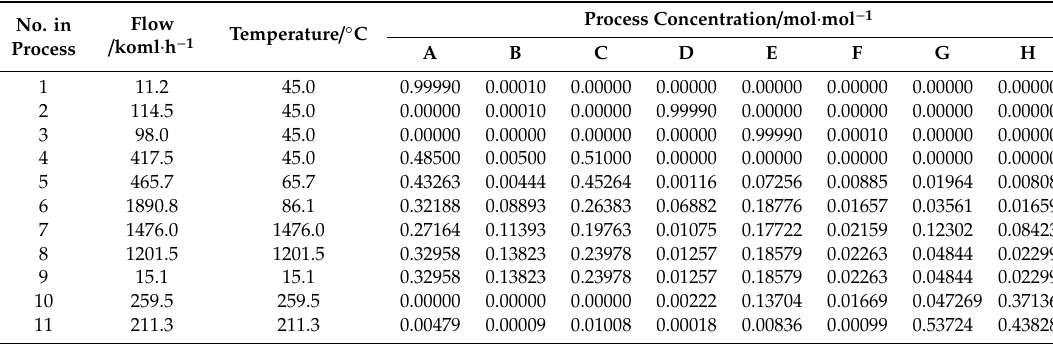
Table 2. Continuous measurement variable (CMV) of the TE